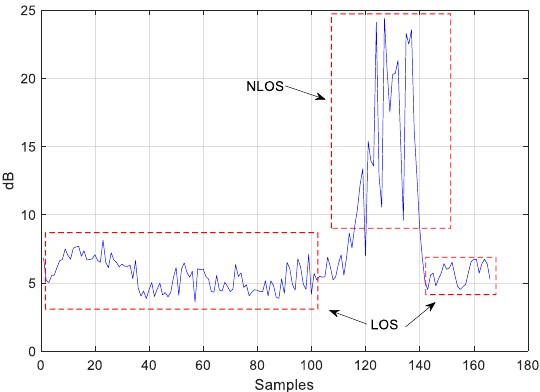
Figure 3. The difference between the received power and signal power in the first path.